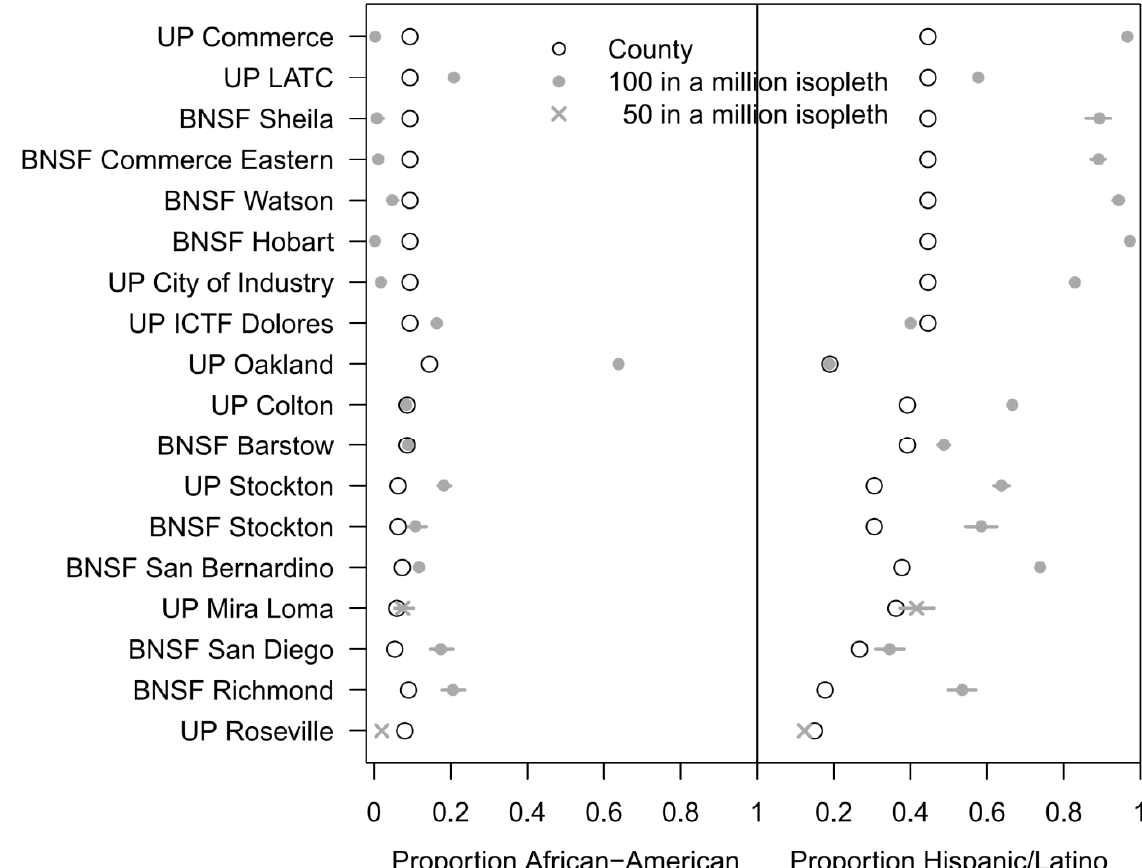
Figure 4. Estimated proportion 1 of African American or Hispanic/Latino 2 residents living in close proximity to rail yards, where proximity is defined by a 50 in a million risk isopleth or 100 in a million risk isopleth, compared to the corresponding population proportions in the county in which the rail yard is located, Table S1. The rail yards are listed in decreasing order of population percentage non-white in the County, 3 Table